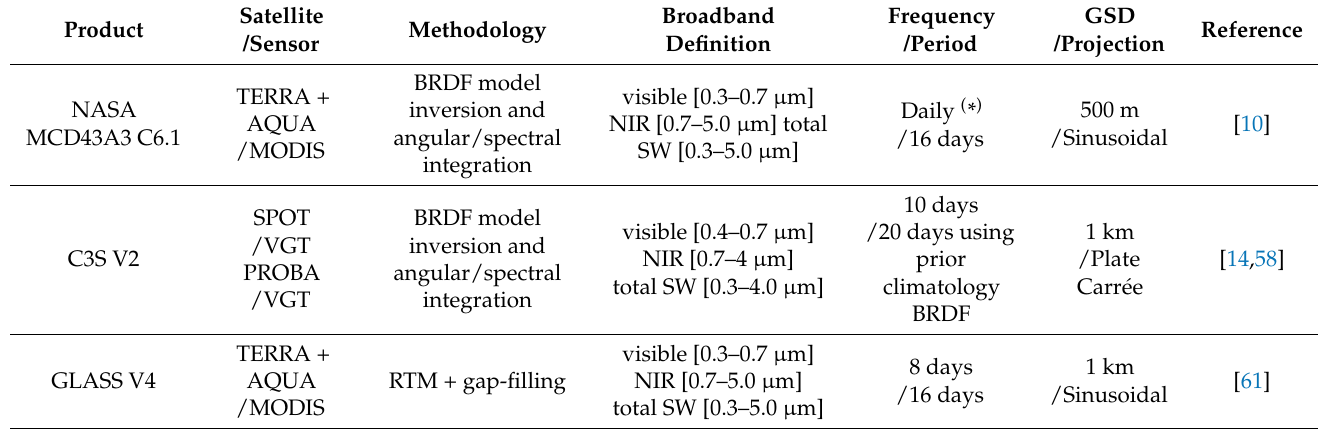
Table 4. Characteristics of the global remote sensing SA products under study. GSD stands for the Ground Sampling